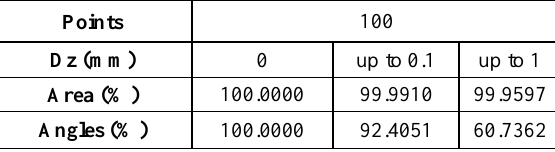
Table 3. Results of the three cases